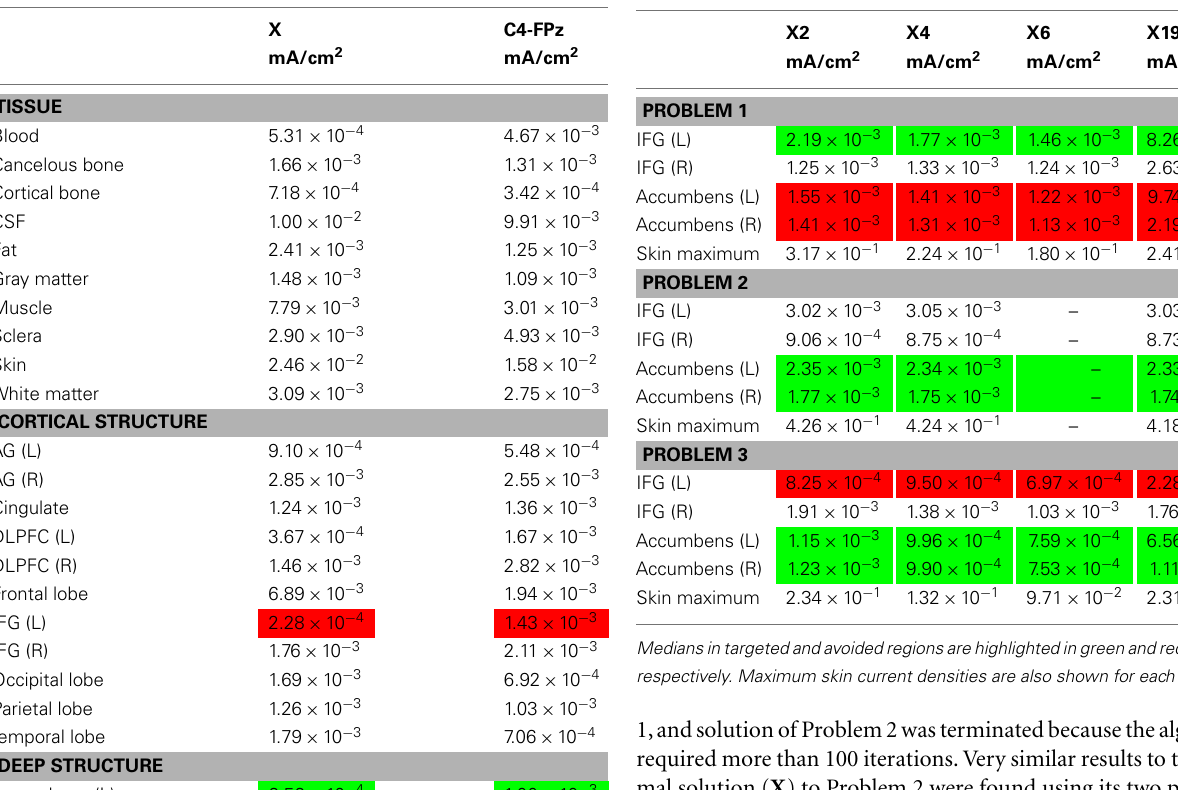
Table 5 | Comparison of effects of using 2-, 4- and 6-electrode patterns based on optimal current